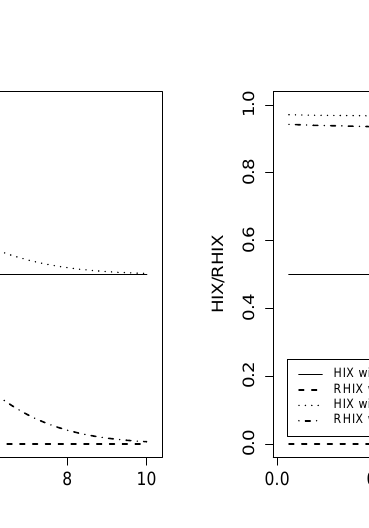
Figure 3: Convergence of the HIX and